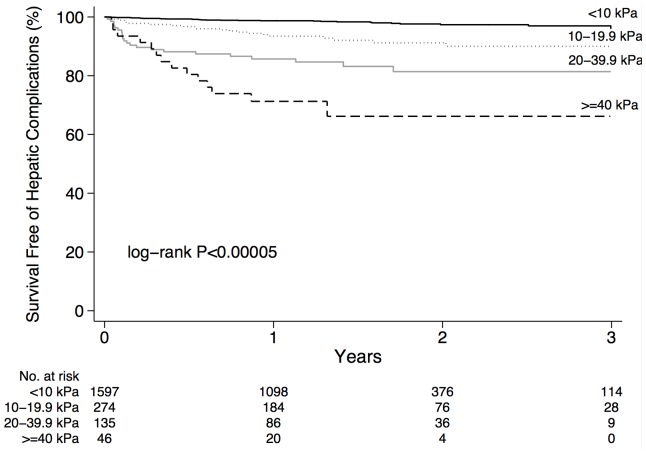
Unadjusted survival free of hepatic complications according to LSM by TE categorized as <10 kPa, 10–19.9 kPa, 20–39.9 kPa, and ≥40 kPa.